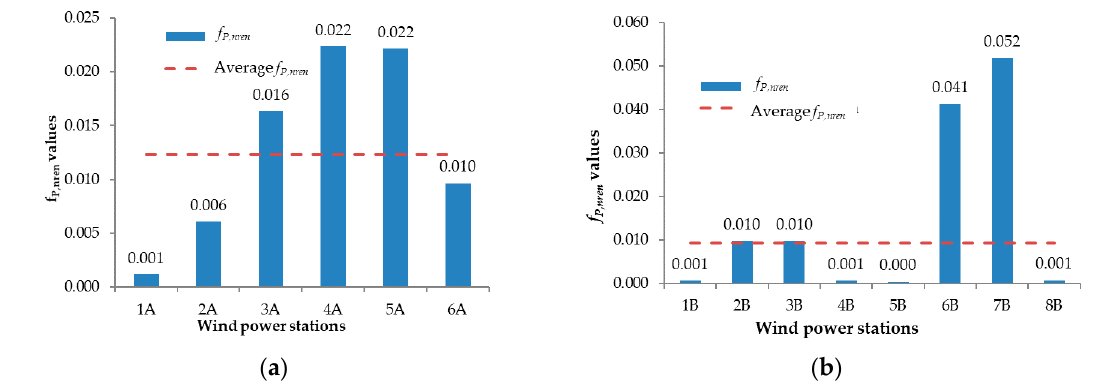
Figure 1. Relationship between f Pnren and wind power in wind turbines/farms: ( a ) In (>10) MW wind turbines; ( b ) in (<10) MW wind turbines.